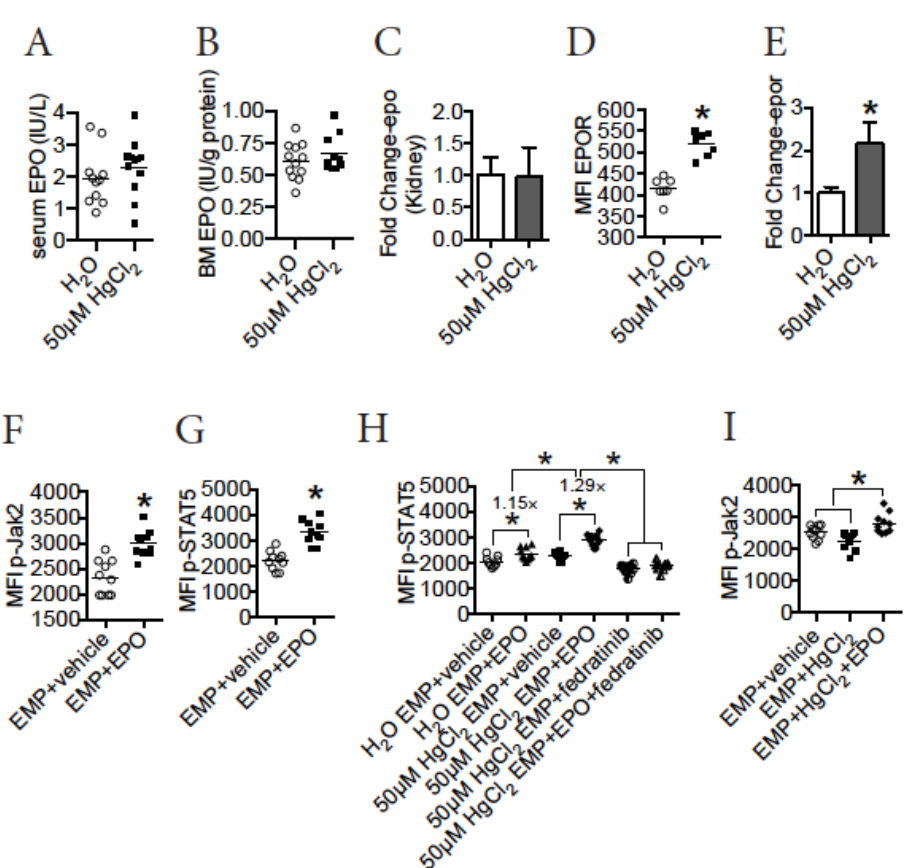
Figure 6. HgCl 2 does not impact the production of EPO, but increases the expression of EPOR in EMPs in B10.S mice. EPO protein in the serum and BM, EPO mRNA in the kidney, and EPOR in EMPs in the BM in B10.S mice treated with 50 µ M HgCl 2 or the control for 4 w were measured. FACS-purified EMPs from the BM of B10.S mice were treated with HgCl 2 or vehicle or EPO in vitro, and the Jak2/STAT5 signaling pathway and differentiation of EMPs were measured thereafter. ( A ) EPO protein (IU/L) in the serum of B10.S mice treated with 50 µ M HgCl 2 or water for 4 w. ( B ) EPO protein (IU/g protein) in the BM of B10.S mice treated with 50 µ M HgCl 2 or water for 4 w. ( C ) EPO mRNA (fold change) in the kidney of B10.S mice treated with 50 µ M HgCl 2 or water for 4 w. ( D ) The expression of EPOR (MFI) in EMPs in the BM of B10.S mice treated with 50 µ M HgCl 2 or water for 4 w. ( E ) The expression of EPOR mRNA (fold change) in FACS-purified EMPs from the BM of B10.S mice treated with 50 µ M HgCl 2 or water for 4 w. ( F ) EMPs were purified from the BM of control B10.S mice, and the FACS-purified EMPs were treated thereafter with EPO or vehicle in vitro for 16 h. After that, the expression of p-Jak2 (MFI) in EMPs was measured. ( G ) EMPs were purified from the BM of control B10.S mice, and the FACS-purified EMPs were treated thereafter with EPO or vehicle in vitro for 16 h. After that, the expression of p-STAT5 (MFI) in EMPs was measured. ( H ) EMPs were purified from the BM of B10.S mice treated with 50 µ M HgCl 2 or water for 4 w, and the EMPs were treated thereafter with EPO or vehicle in the presence or absence of the Jak2 inhibitor fedratinib for 16 h in vitro. After that, the expression of p-STAT5 (MFI) in the EMPs was measured. ( I ) EMPs were purified from the BM of control B10.S mice, and the FACS-purified EMPs were treated thereafter with HgCl 2 and/or EPO or vehicle in vitro for 16 h. After that, the expression of p-Jak2 (MFI) in EMPs was measured. Each dot represents one mouse or one sample, and a total of 5 to 12 mice or samples were used for each group. Asterisk indicates a significant difference compared to the counterpart control group. p < 0.05 was considered as the level of significant